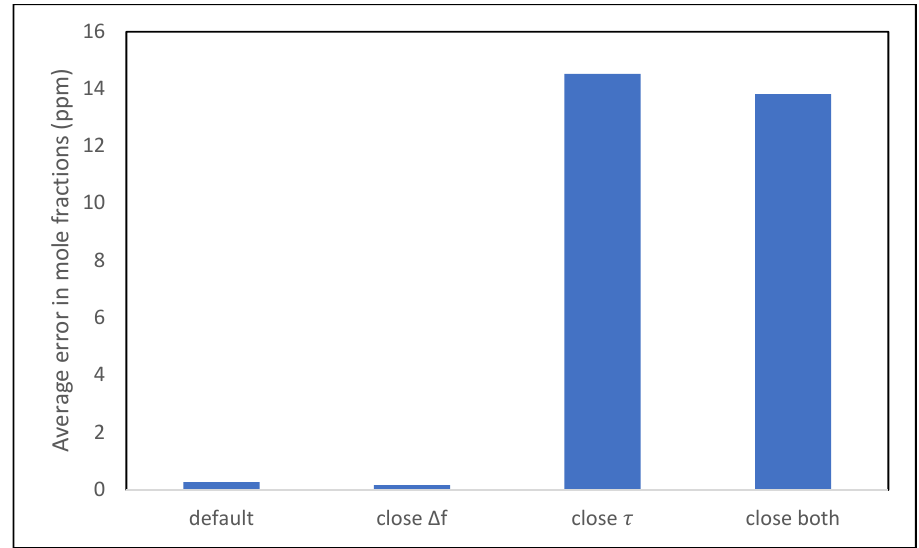
Figure 5. The average error in mole fraction values (ppm) for the four different cases. Using the two different apparatuses for generating vapor concentrations at high and low values, it was found that the time constant was independent of concentration from fits of the data using Equation (6). Thus, it can be inferred that, for a film of con- stant thickness, time constants obtained at higher concentrations will be applicable at lower ones as well. Table 7. Comparison of regressed mole fractions y 1, amb , y 2, amb , and y 3, amb from Equation (8) to actual mole fractions y 1, act y 2 ,act and y 3, act of benzene, toluene, and ethylbenzene, respectively.